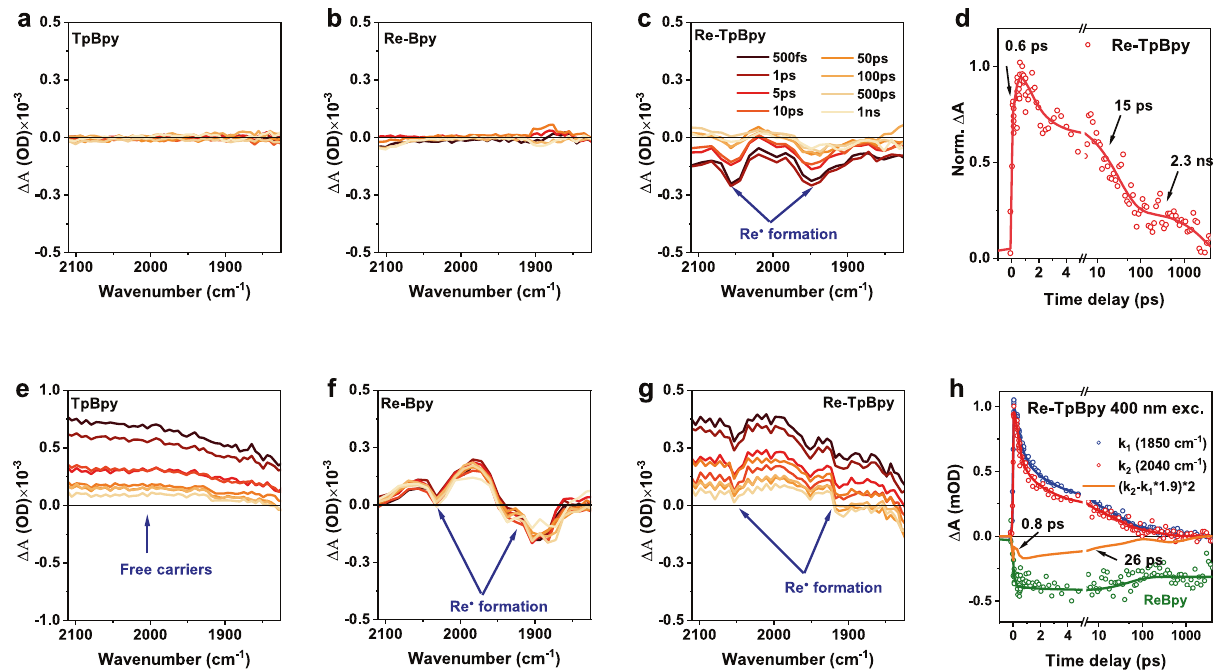
Fig. 7 TRIR study of the samples. TRIR spectra of TpBpy, Re-Bpy, and Re-TpBpy excited at 530 nm ( a – c ) and 400 nm ( e – g ). TRIR kinetics at 2040 cm − 1 of Re-TpBpy excited at 530 nm. ( h ) TRIR kinetics at 2040 cm − 1 (red), 1850cm − 1 (blue) and their differential curve (orange) of Re-TpBpy excited at 400 nm. The kinetics at 2040 cm − 1 of Re-Bpy excited at 400 nm is also presented (green). All spectra are recorded in Na fi on (5% w/w in water and 1- propanol). Source data are provided as a Source data fi